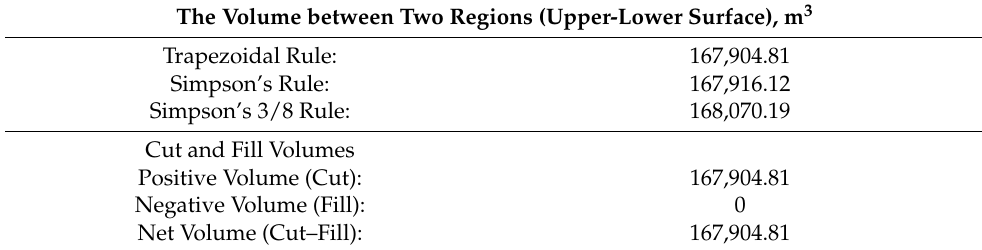
Figure 14. Volume calculation of mass sliding at landslide Hulu Yam study area: ( a ) 3-D upper surface of landslide area; ( b ) 3-D lower surface of failure plane; ( c ) 3-D illustration of a volume of mass sliding calculation between two different maps (upper–lower).